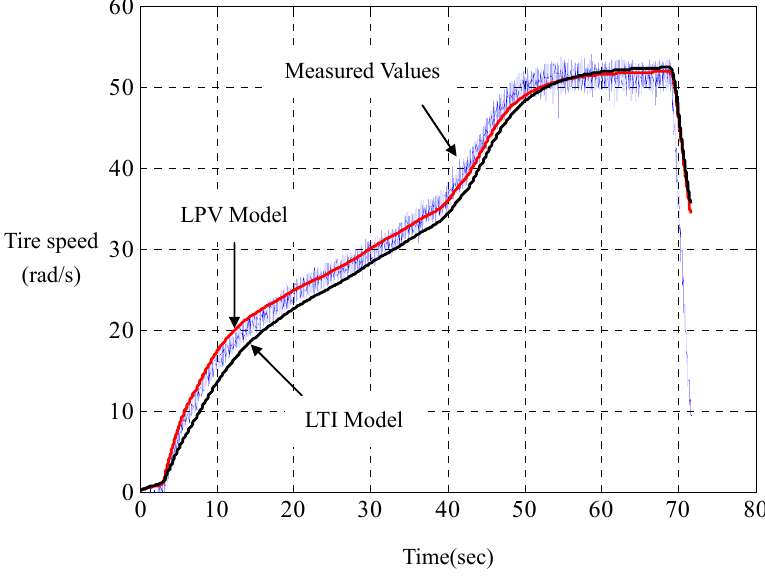
Figure 6. Speed comparison of LPV with LTI